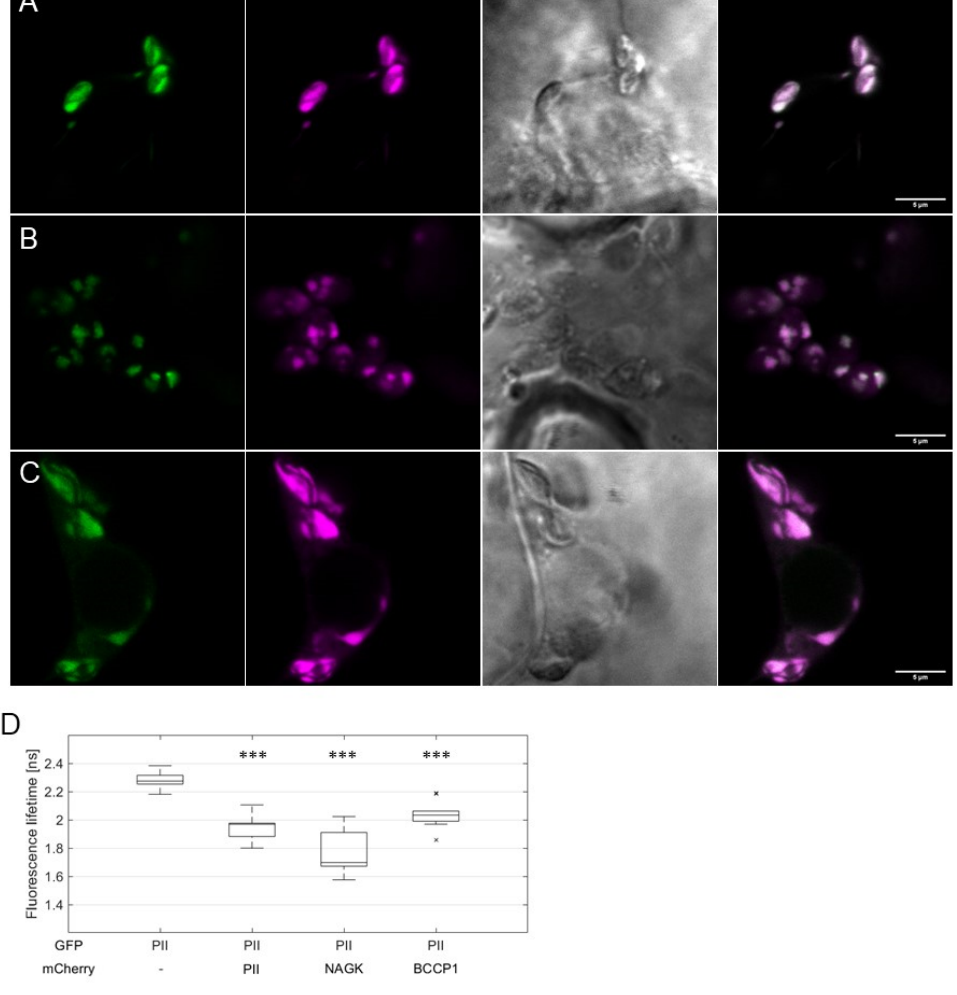
Figure 4. FRET/FLIM analysis of At PII interaction with candidate proteins in PII foci. At PII-GFP was co-expressed with At PII-mCherry ( A ), At NAGK-mCherry ( B ), and At BCCP1-mCherry ( C ), respectively, under the control of p35S promotor in N. benthamiana using 2in1 FRET vectors. Images were taken 2 days after transient transformation of N. benthamiana . In each row, the fluorescence of GFP is shown first, mCherry (magenta) is shown second, the brightfield image is shown third, and the merge of both fluorescence pictures is shown is shown last. Scale bar: 10 µ m. ( D ) FLIM analyses of fluorescent co-localising signals in ( A – C ). Student’s t -test used for calculation of significance. Data points marked with an “x” represent statistical outliers of measurement. *** p < 0.001.